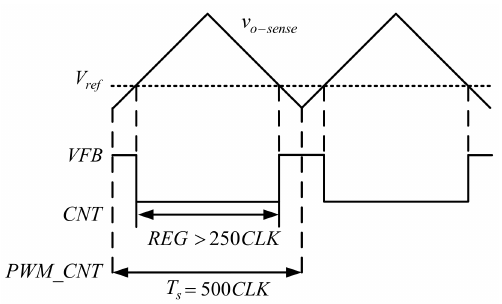
Figure 11. Average value of v o-sense greater than the value of V ref .